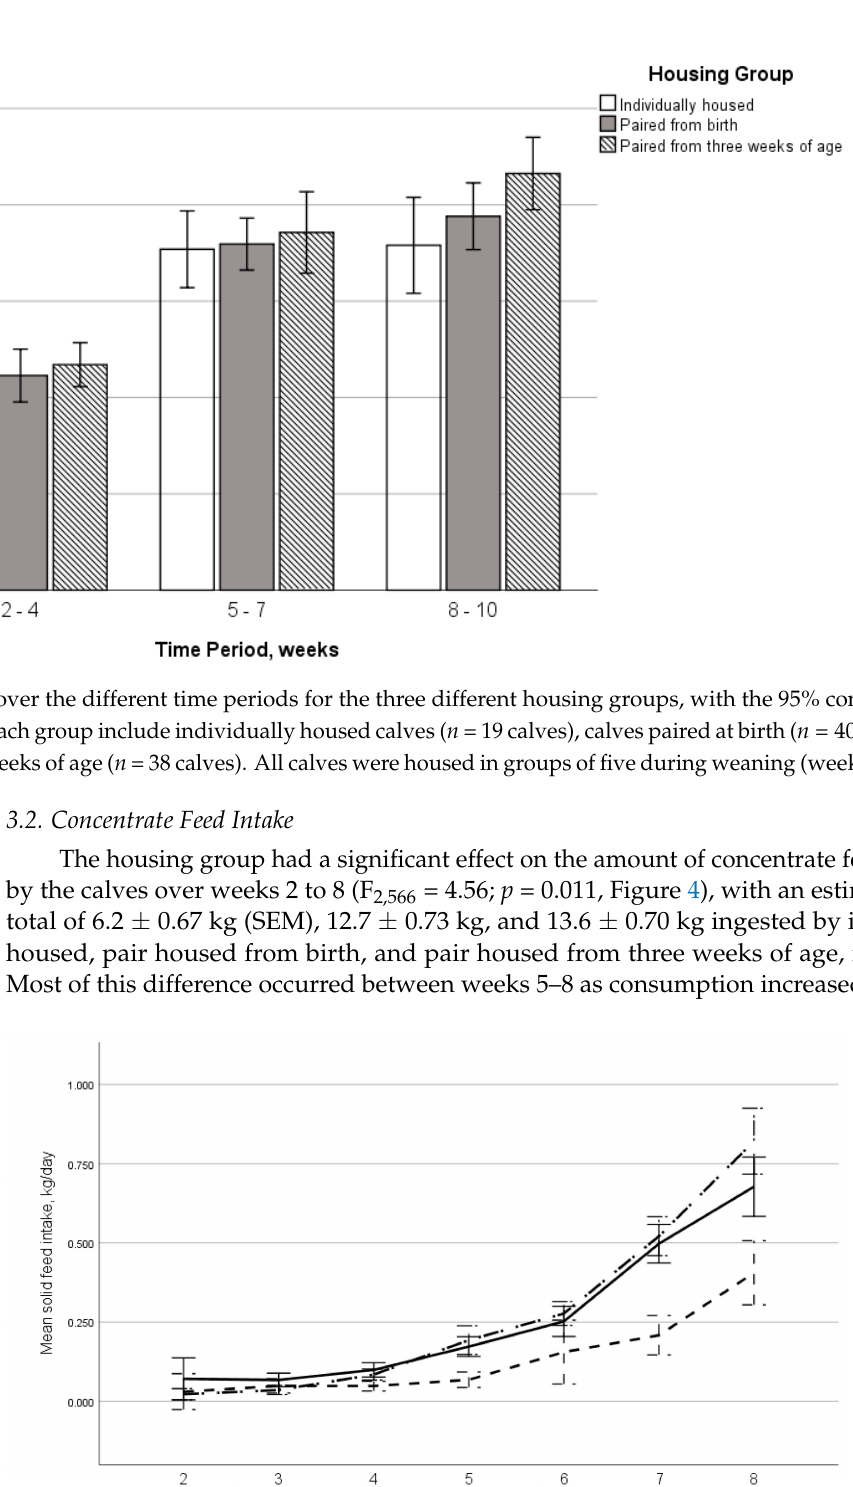
Figure 4. Mean measured concentrate feed consumption between visits at 2 to 8 weeks of age for the different housing groups of calves, with the 95% confidence interval shown as error bars. The line indicates the individually housed calves ( n = 19 calves), the line indicates the calves paired at birth ( n = 40 calves), and line indicates the calves paired at three weeks of age ( n = 38 calves).